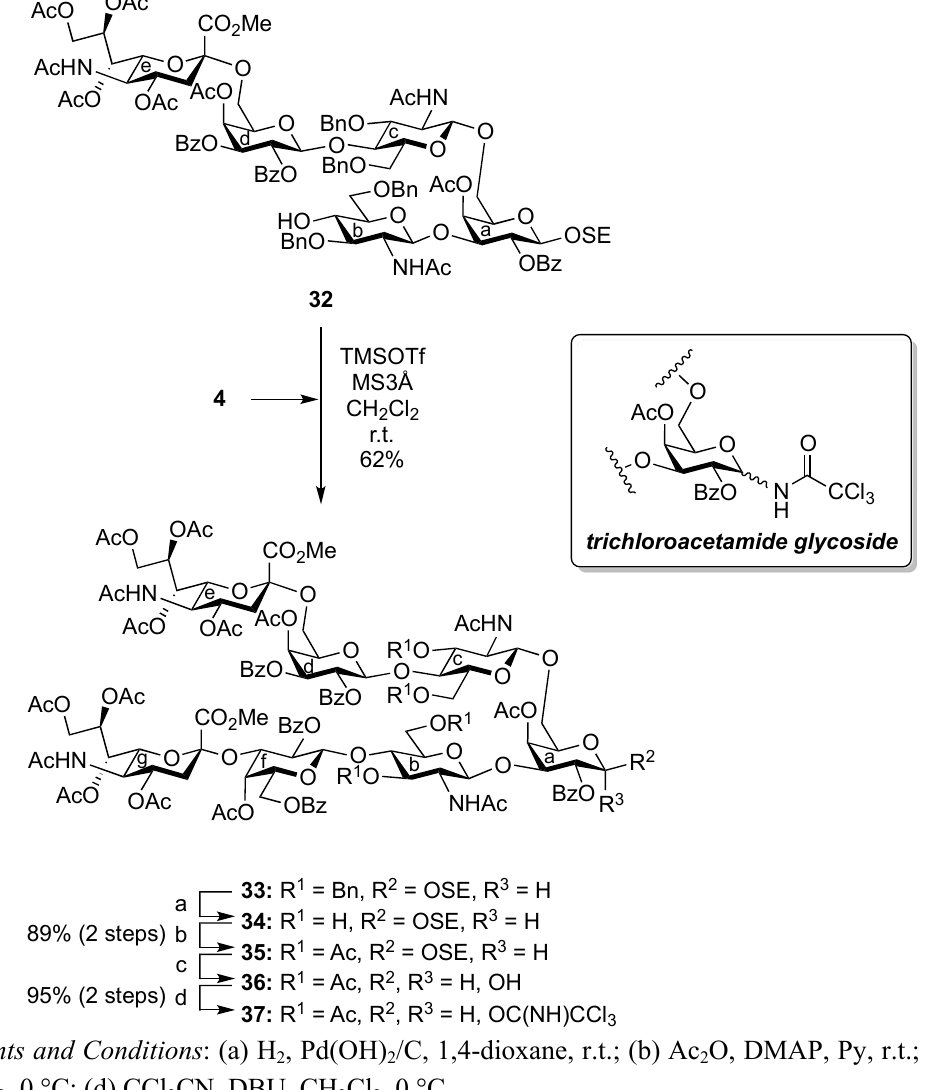
Scheme 5. Synthesis of the non-reducing end heptasaccharide